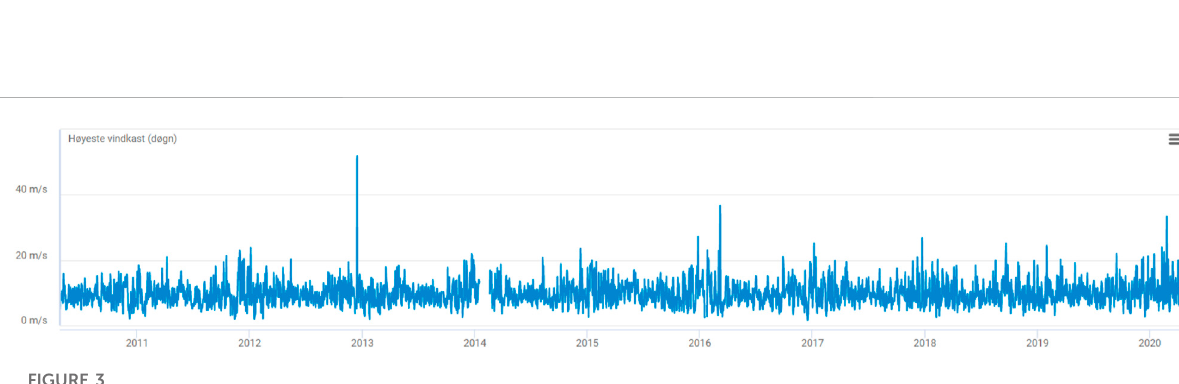
Wind speed measurements locations according to Norwegian Meteorological Institute. The blue circle indicates the area of